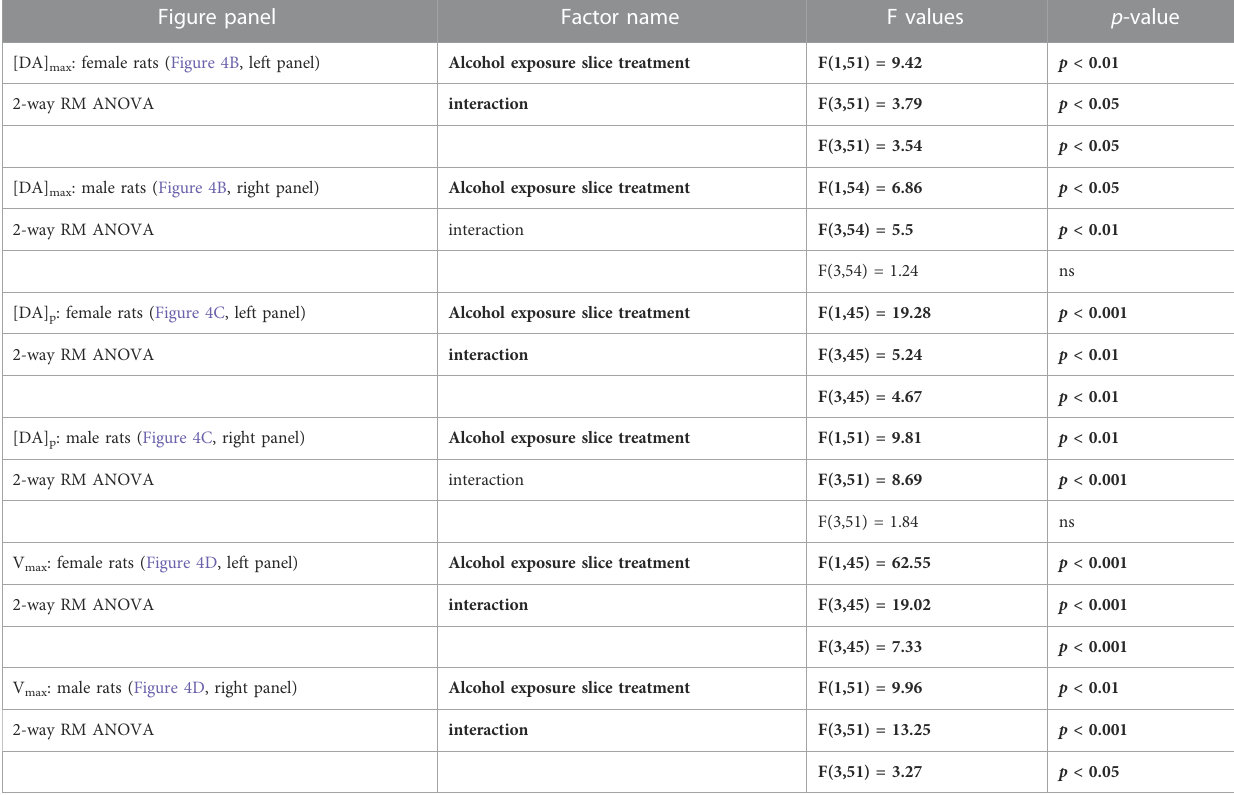
TABLE 2 Statistical analysis of the Baclofen ’ s regulation of evoked dopamine release within the NAcc, presented on Figure 4. Statistical analysis of the Baclofen ’ s regulation of evoked dopamine release within the NAcc. Bold characters indicate a signi fi cant main effect and/or an interaction following a 2-way RM ANOVA. Figure panel Factor name F values p -value [DA] max : female rats (Figure 4B, left panel) Alcohol exposure slice treatment F(1,51) = 9.42 2-way RM ANOVA interaction